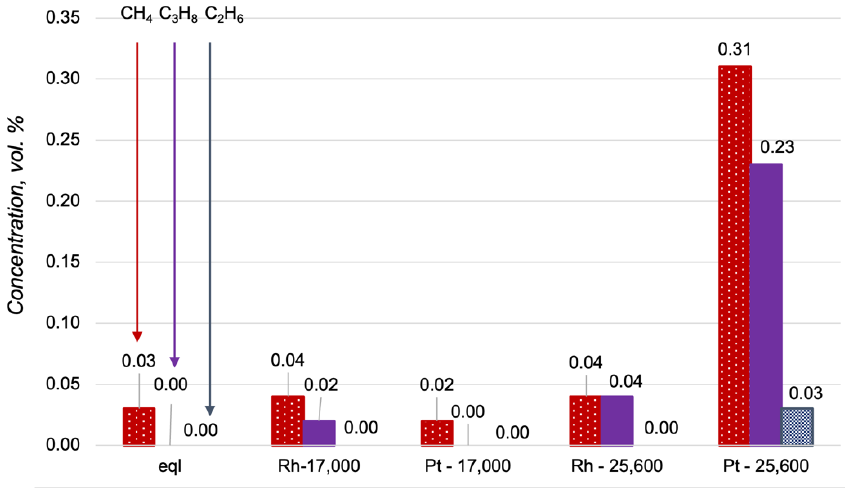
Figure 8. Hydrocarbon content in the products of the propane oxidative steam reforming at 700 °C, with H 2 O/C = 2.5 O 2 /C = 0.5 in a thermodynamic equilibrium (eql), over the Rh/CZA/FeCrAl and the Pt/CZA/FeCrAl at GHSV = 17,000 h − 1 (“Rh—17,000” and “Pt—17,000”, respectively), and over the Rh/CZA/FeCrAl and the Pt/CZA/FeCrAl at GHSV = 25,600 h − 1 (“Rh—25,600” and “Pt—25,600”,